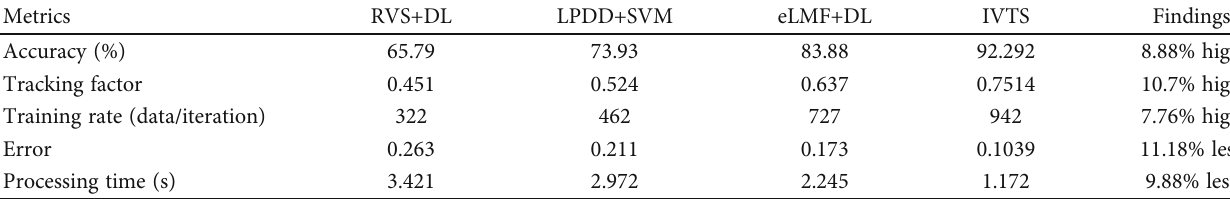
Table 1: Comparative analysis results for